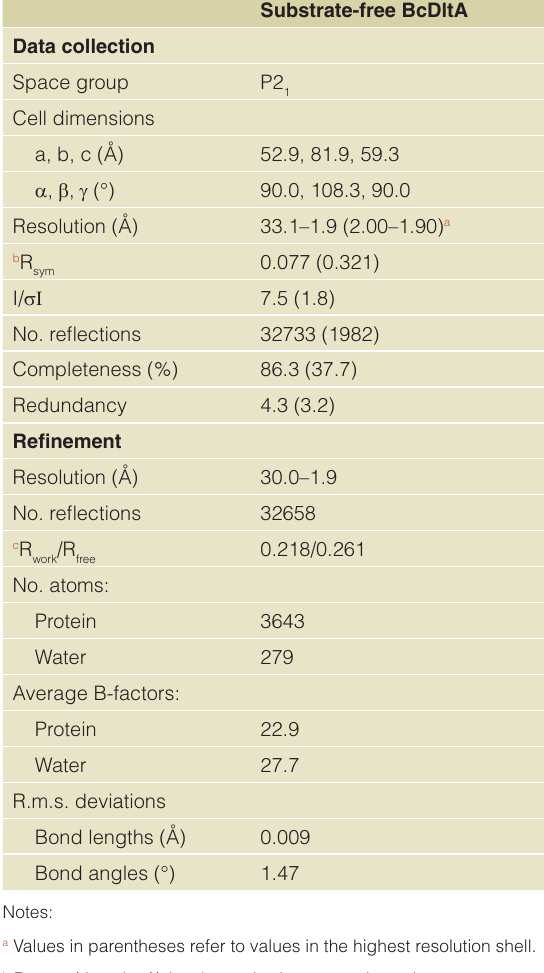
Table 1. X-ray crystallographic data collection and structure refinement